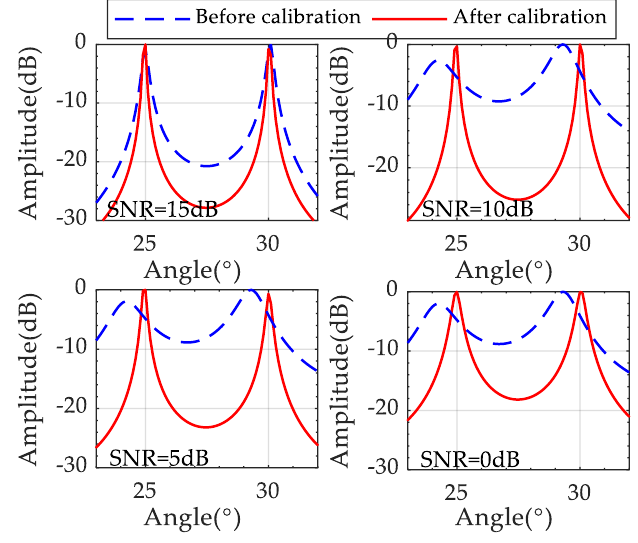
Figure 11. The DOA results at di ff erent SNR.